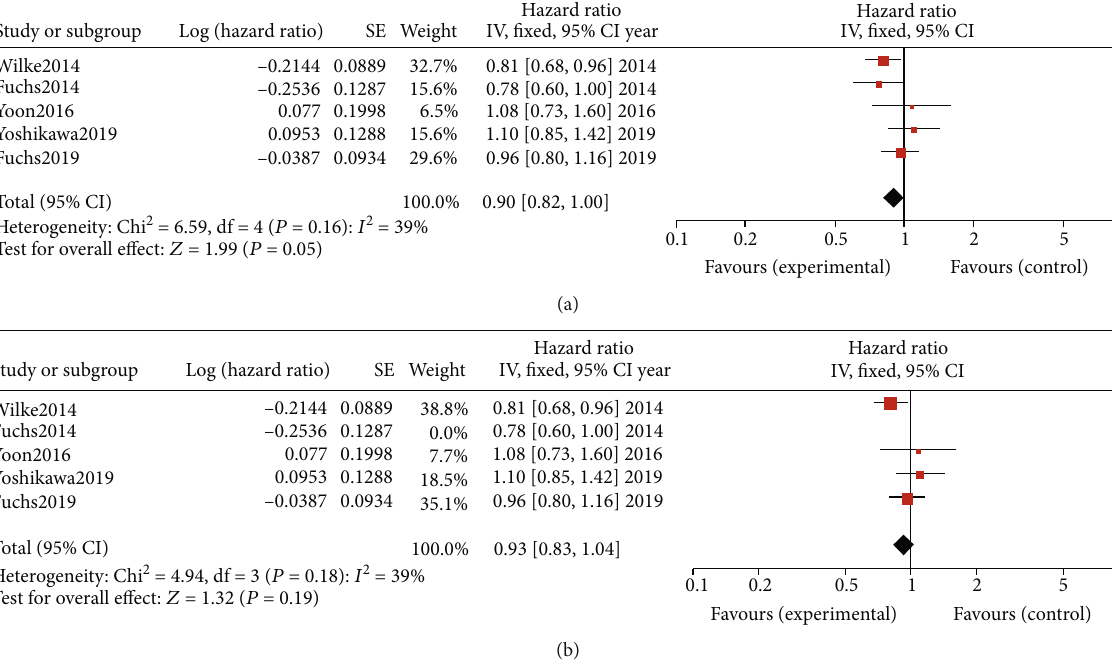
Figure 2: (a) Pooled analysis of overall survival (OS) comparing the application of ramucirumab (RAM) alone or plus chemotherapy with the control (placebo or chemotherapy). (b) Pooled analysis of OS comparing the application of RAM alone or plus chemotherapy with chemotherapy